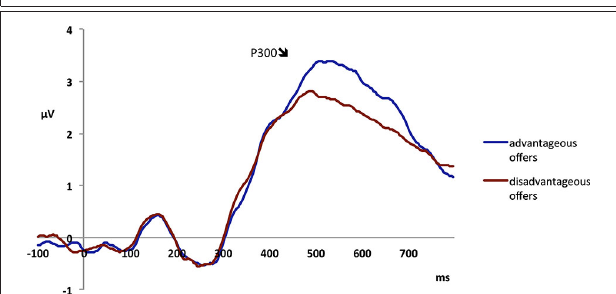
FIGURE 7 | Electrophysiological data shows that advantageous offers, in which the participant is offered the higher part of the split, elicit higher P300 amplitudes than disadvantageous